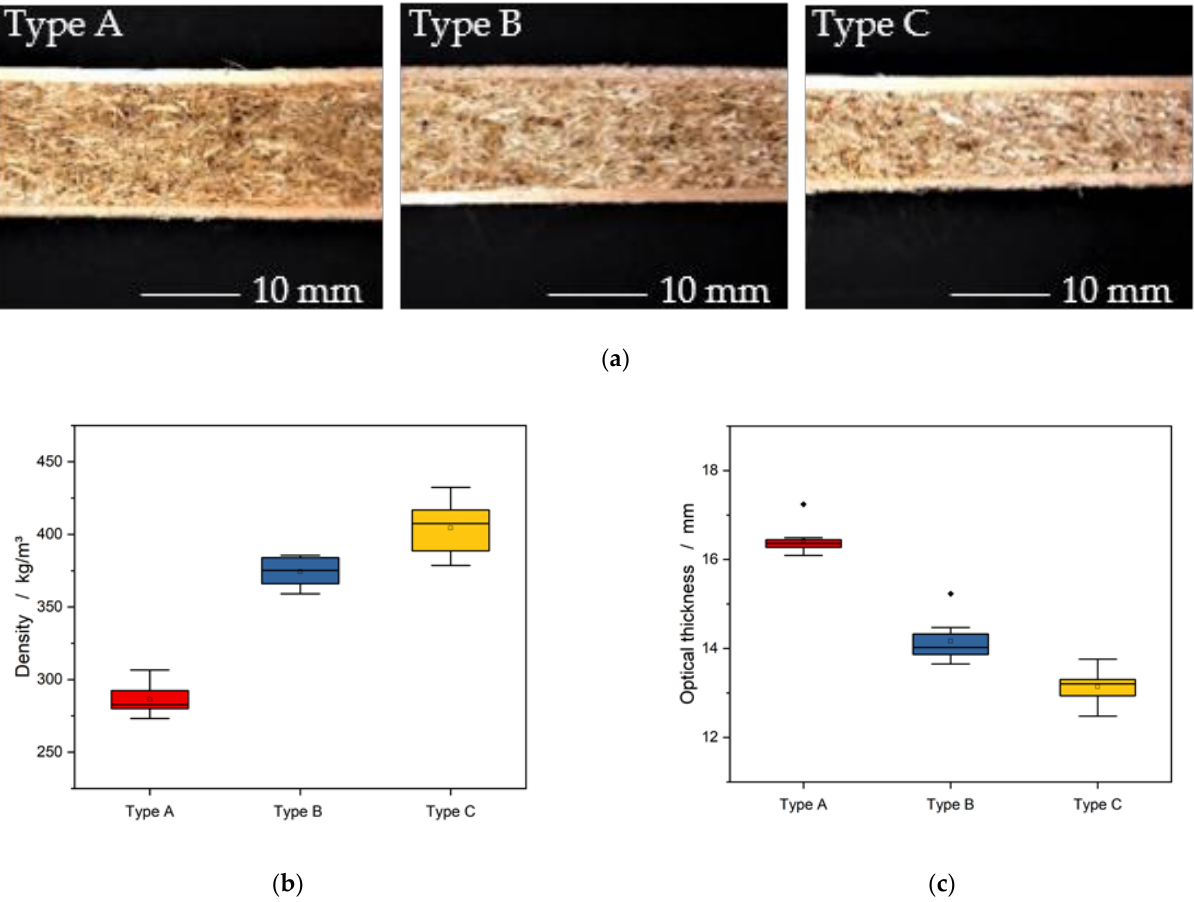
Figure 2. ( a ) Cross-section of the produced loofah sandwich panels of different types, with associ- ated mean density ( b ) and panel thickness ( c ). mean density ( b ) and panel thickness ( c